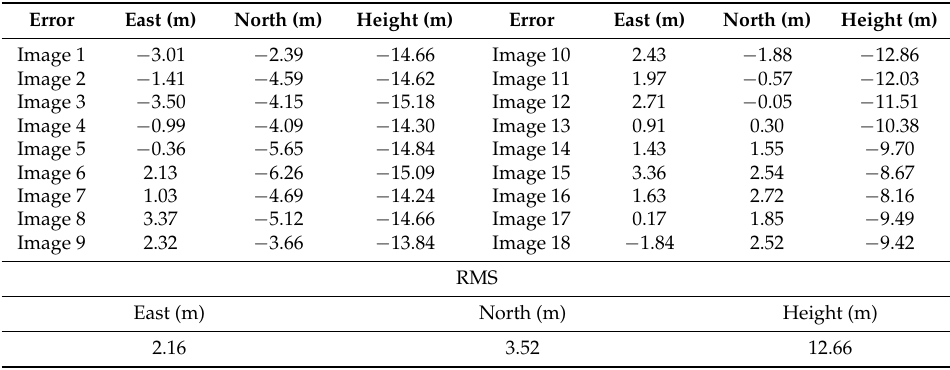
Table 3. The corrected initial position of the Station’s camera absolute accuracy.